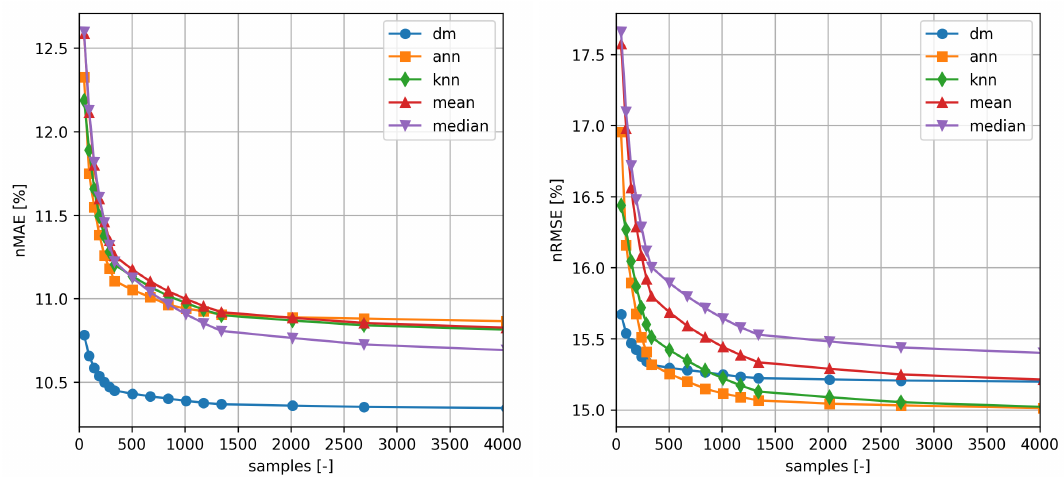
Figure 5. Normalized MAE and RMSE as a function of the training set samples size, for turbine 1.